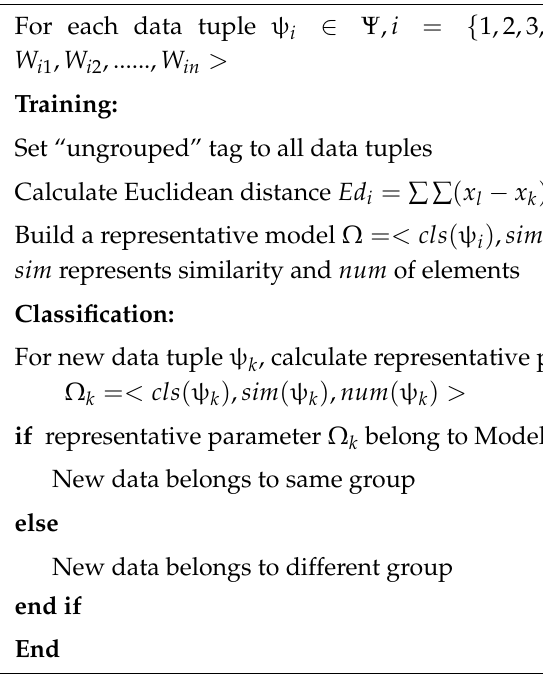
Algorithm 1 kNN